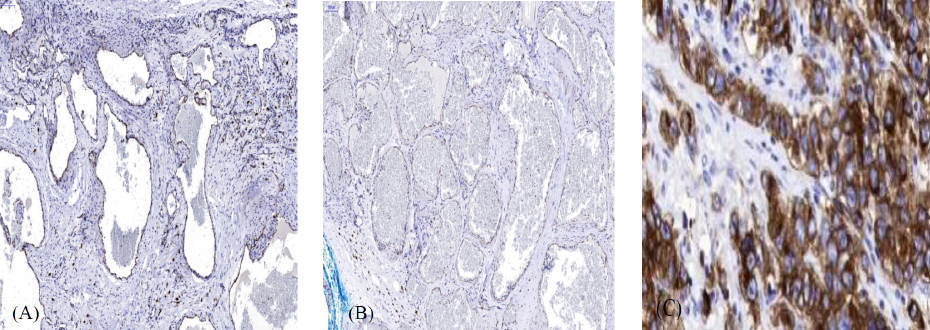
Figure 2. ( A ). Representative cavernous hemangioma with strong immunohistochemical staining positivity for the c-KIT receptor in endothelial cells. ( B ). Representative cavernous hemangioma with weak immunohistochemical staining positivity for the c-KIT receptor in endothelial cells. ( C ). Gastrointestinal stromal tumor served as a positive control. (magnification × 300. Scale bar 100 µ m).